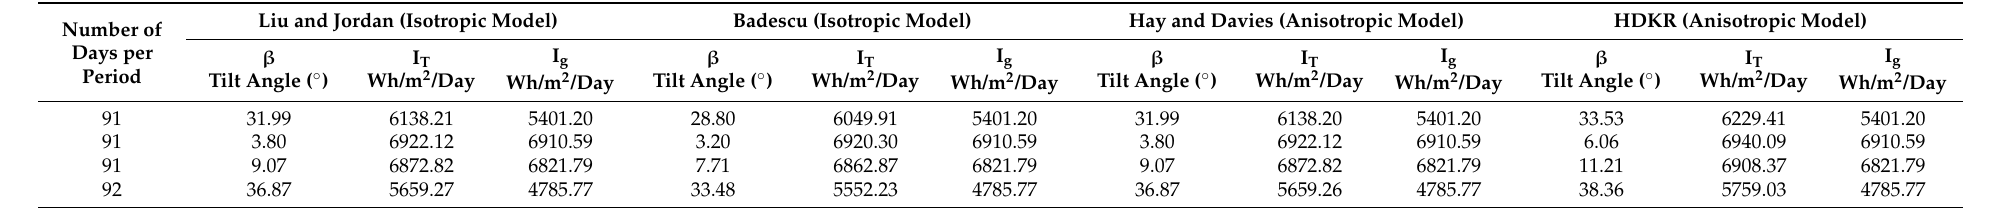
Table 7. Optimal tilt angles and solar radiation results for Makkah